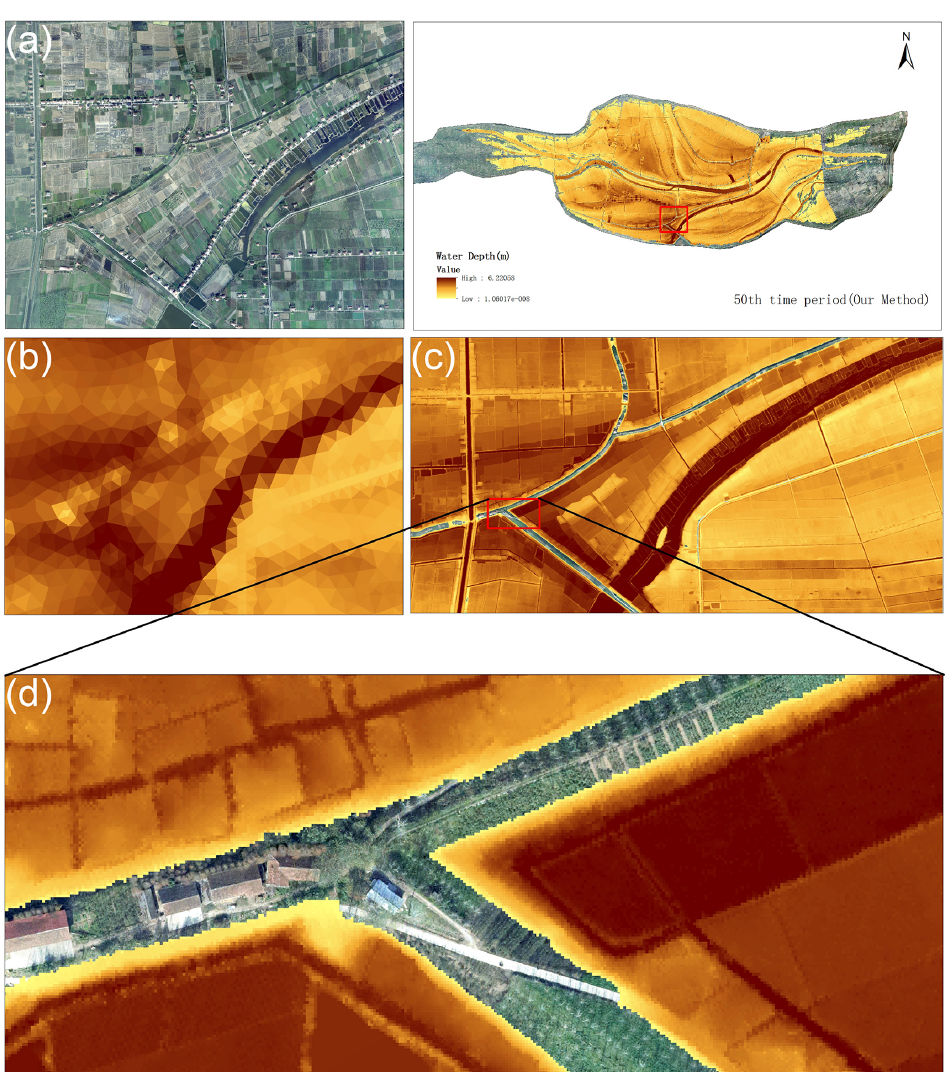
Figure 11. The scheme of the inundation process on the 50th time period and its regional enlarged view. (a) shows the high-resolution aerial remote sensing image taken by the airborne lidar system; (b) and (c) show the 2-D hydraulic model’s and our method’s regional enlarged view of the inundation area, respectively; (d) shows the levee crests on which houses and roads are being constructed.